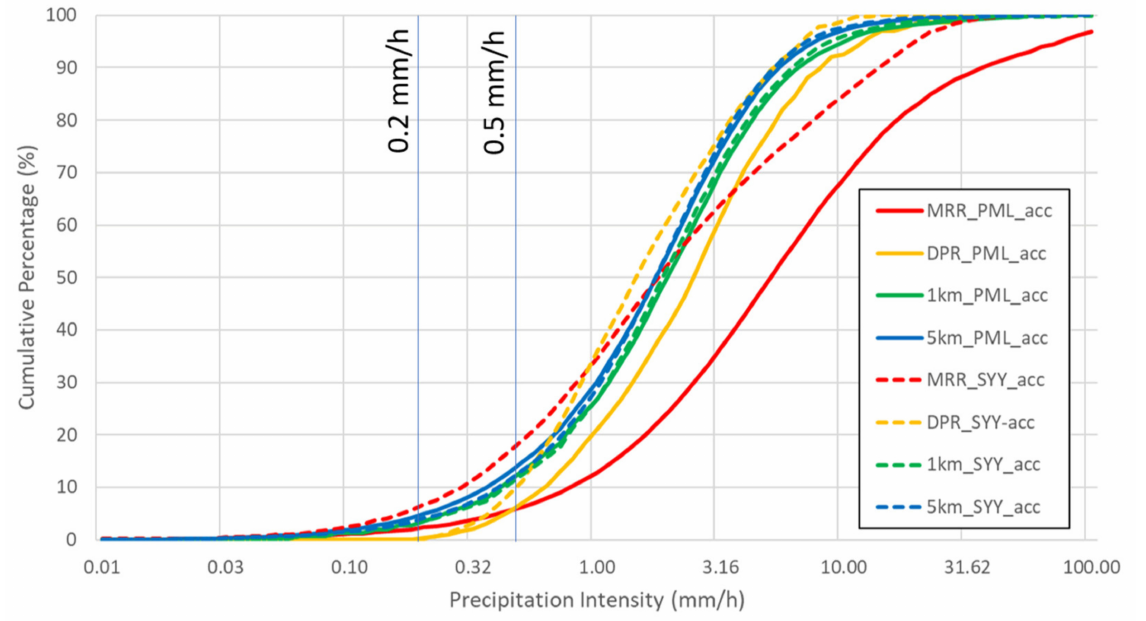
Figure 3. Accumulation of precipitation as observed at the PML (continuous lines) and SYY (dashed lines) locations for the MRR (red), DPR (yellow), 1-km radar (green) and 5-km radar